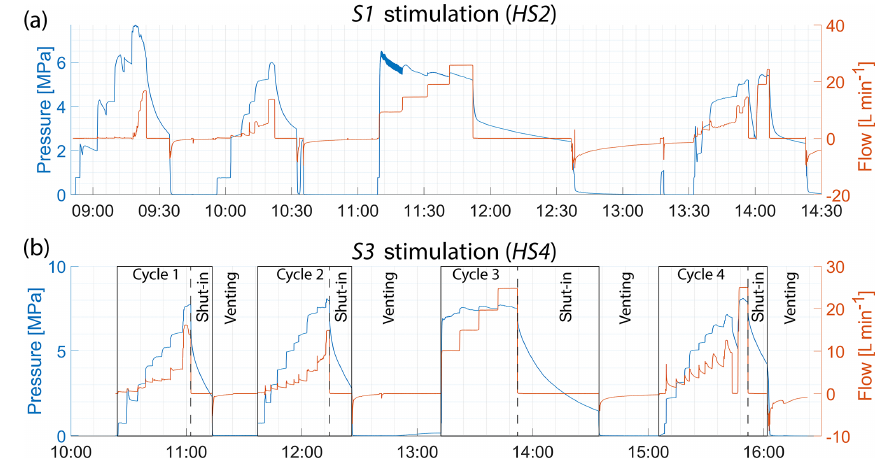
Figure 4. Injection protocol for (a) experiment HS2, which targets S1 structure S1.2, and (b) experiment HS4, which targets S3 structure S3.1. The various phases of the four cycles performed in each experiment are indicated in (b) . Similar plots for all other intervals are presented in Fig. A2 of the Appendix.